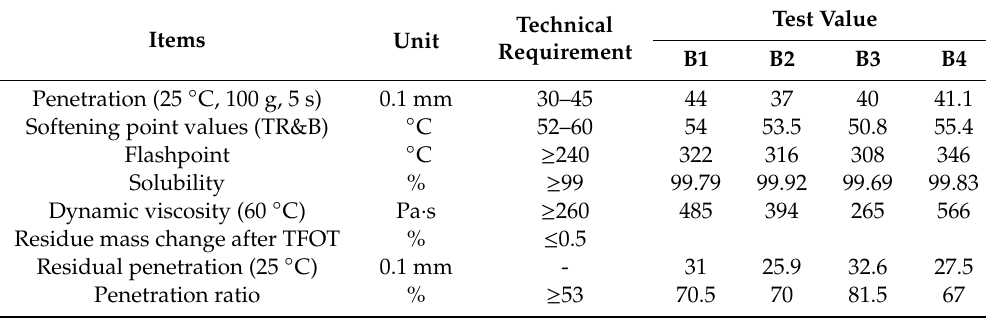
Table 1. Test results on matrix asphalt.